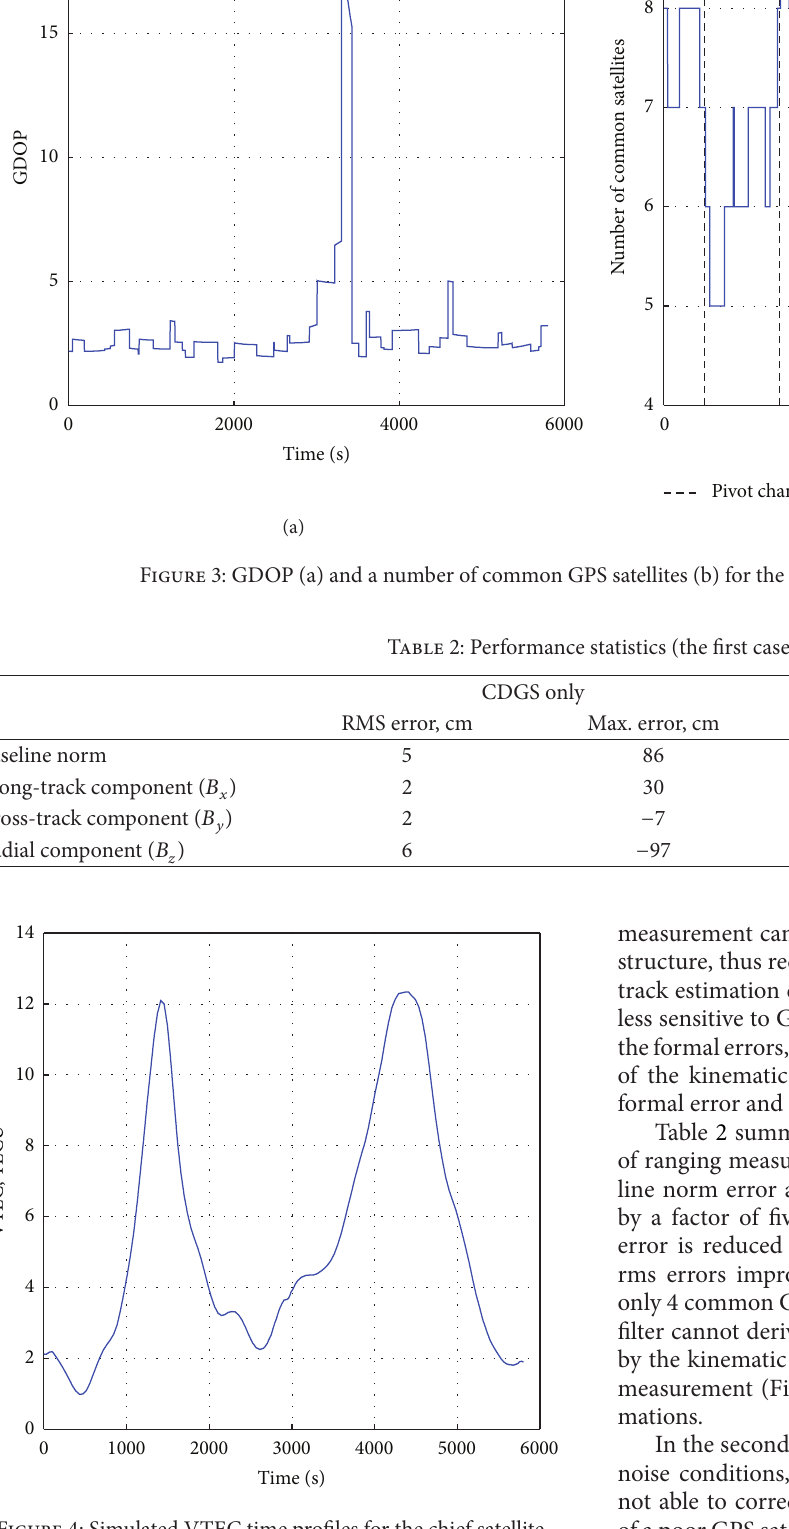
Figure 4: Simulated VTEC time profiles for the chief